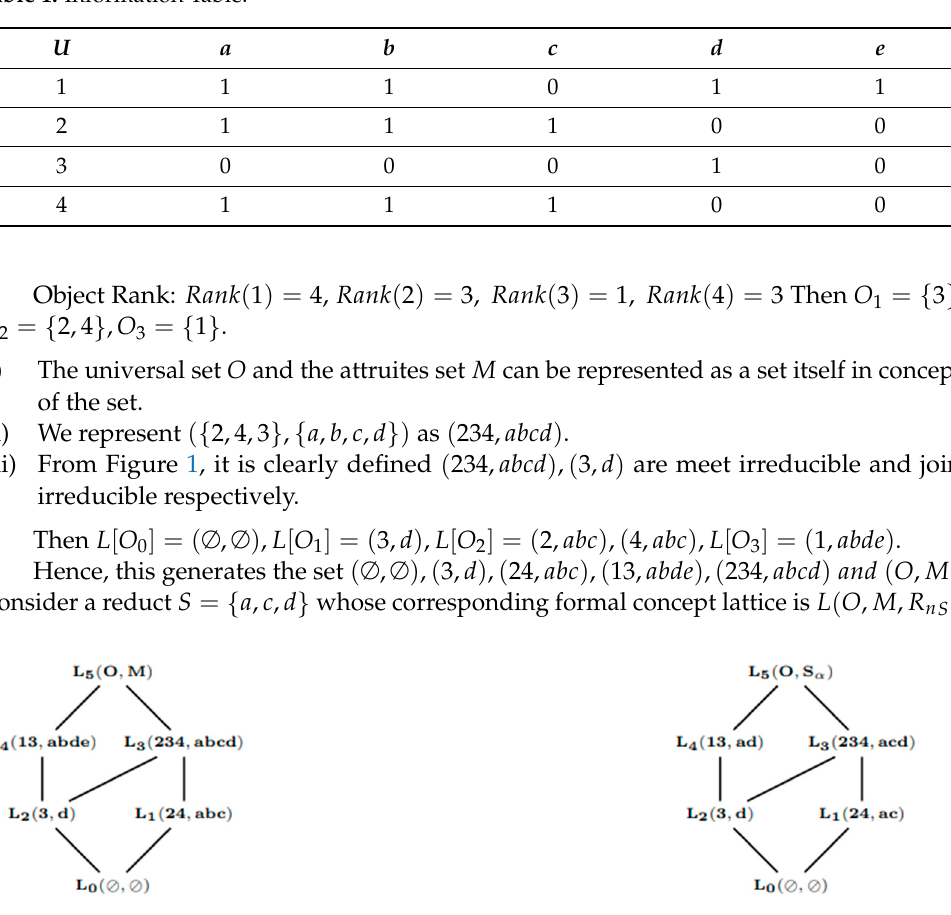
Table 1. Information Table.